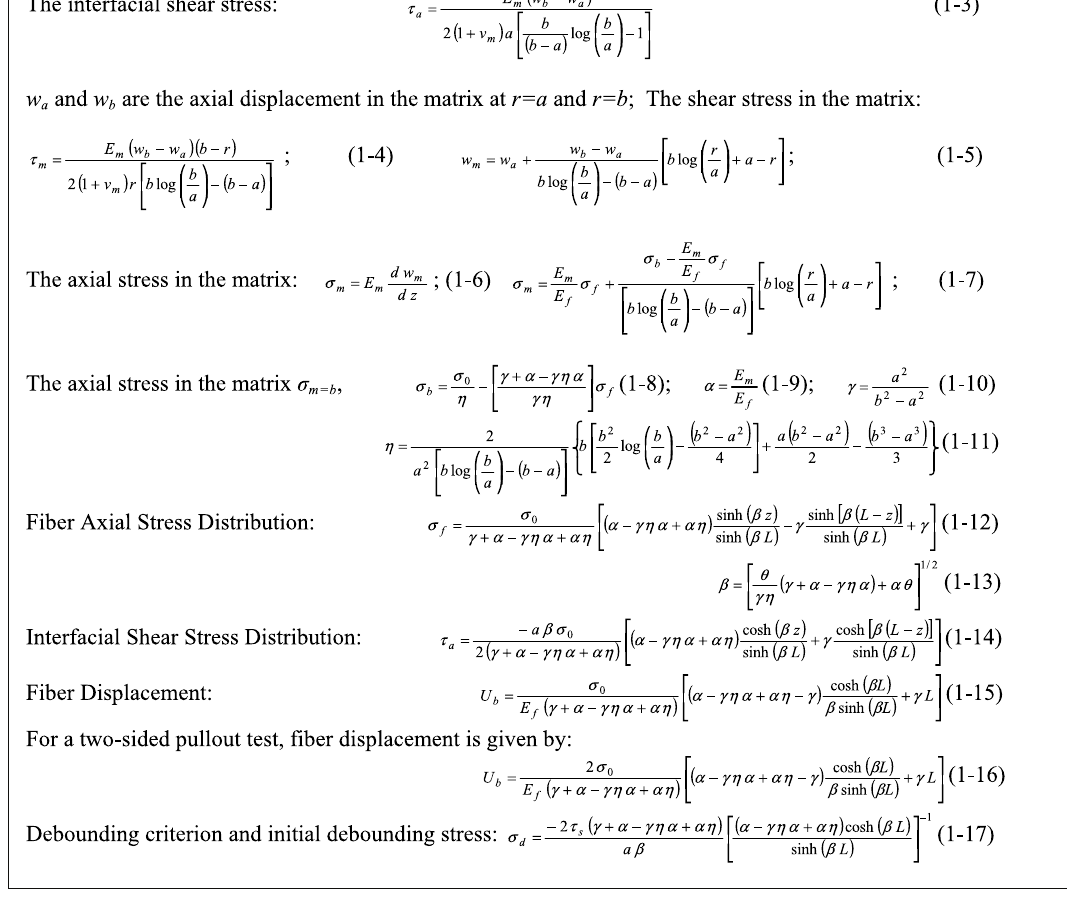
Figure 1. Stage 1 – fiber completely bonded along the length of the fiber with the relevant